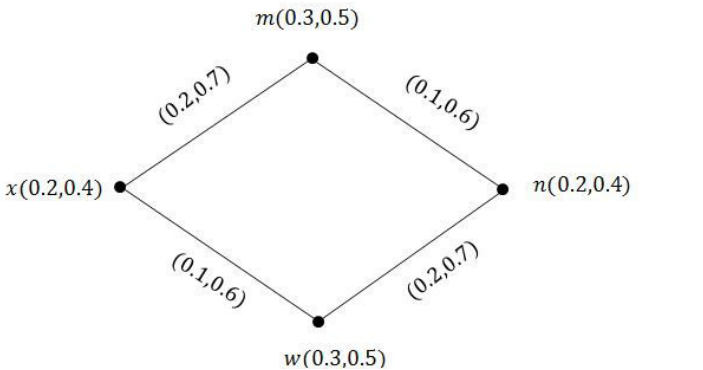
Figure 10. Both Neighborly Edge Irregular (NEI) and Neighborly Edge Totally Irregular Vague Graph